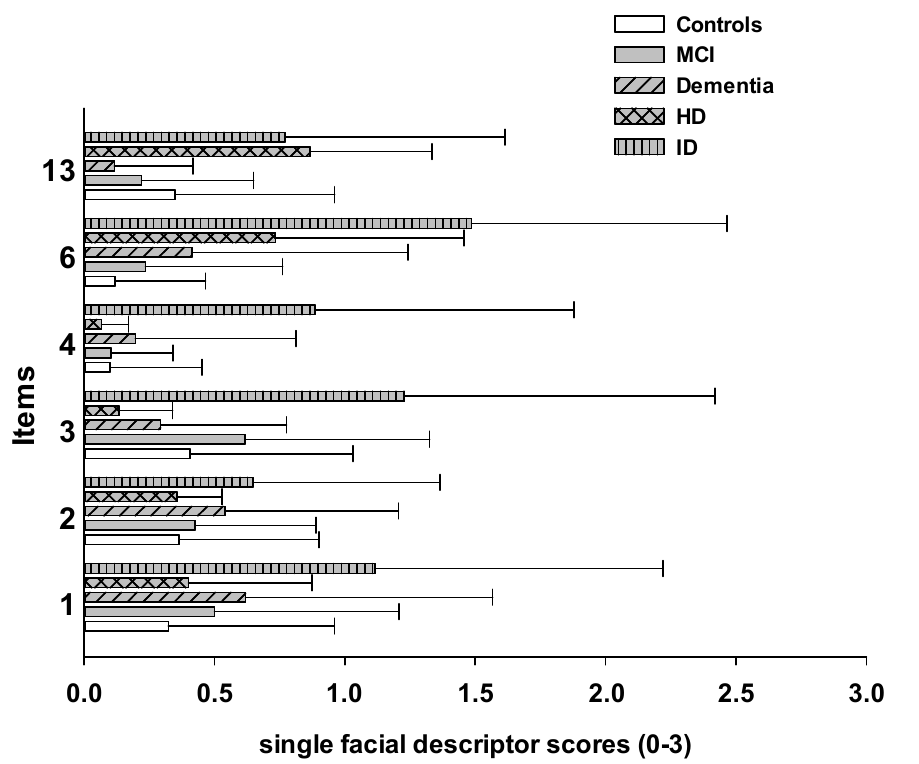
Figure 4. Step 3, encoding—post-hoc comparisons between types of cognitive impairment: Com- paring single facial descriptor scores (mean, SD) (during 400 kPa pressure pain) of individuals with different types of cognitive impairments.